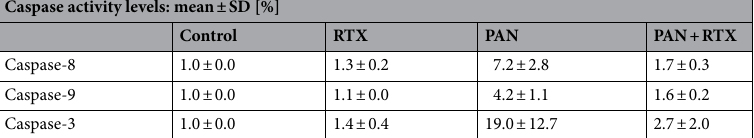
Table 3. Rituximab prevents Caspase activation in human podocytes. Cleaved Caspase-8, -9 and -3 activity levels were measured by Western-blot analysis for the detection of apoptosis. RTX = rituximab (100 µg/ml); PAN = puromycin aminonucleoside (30 µg/ml). Treatment time: 48 h; n = 3 experiments; Data are means (%) ± SD.